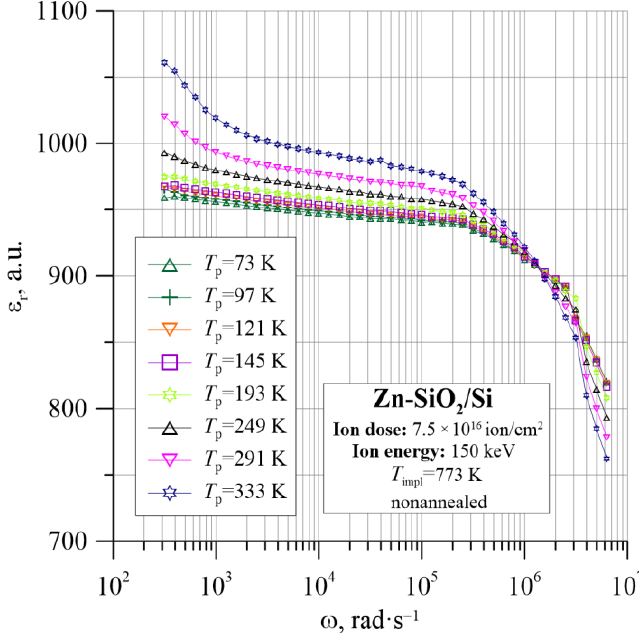
Figure 5. Temperature dependence of the real part of dielectric permittivity ε r for the Zn-SiO 2 /Si nanocomposite immediately after preparation under “ hot ” implantation conditions (150 keV, 7.5 × 10 16 ion/cm 2 , T impl = 773 K).